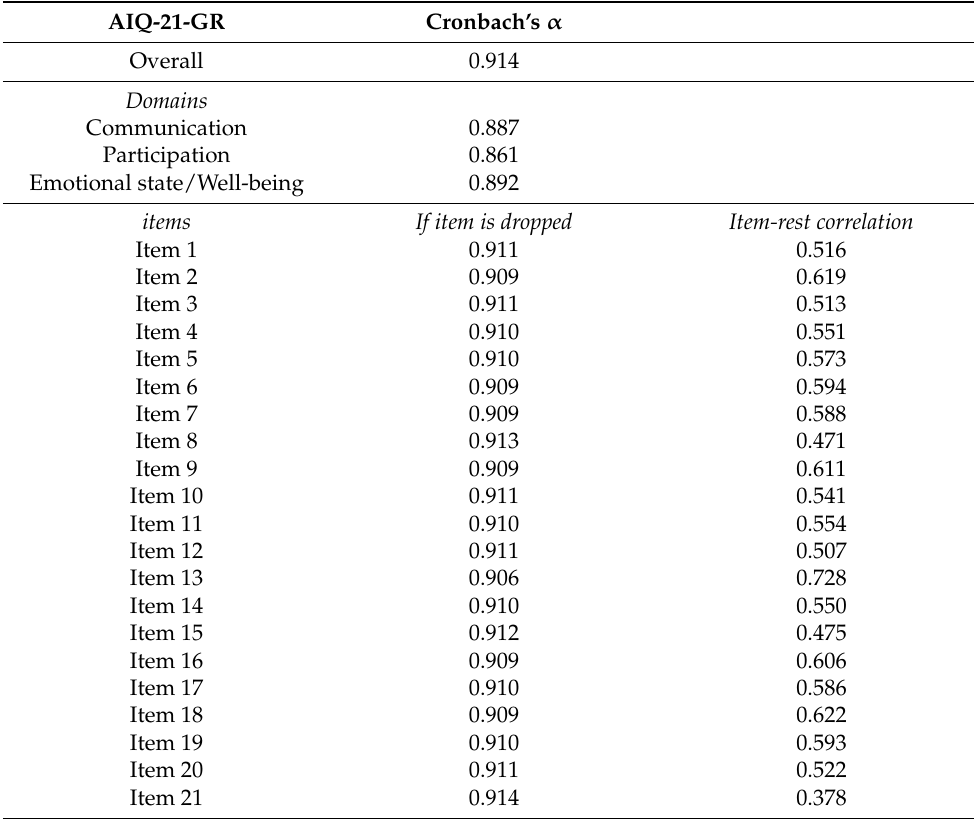
Table 4. Reliability analysis of